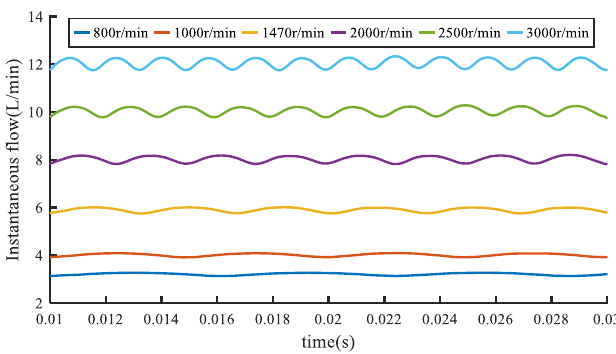
Figure 9. Contrast curves of simulated instantaneous flow of gear pumps at different speeds.